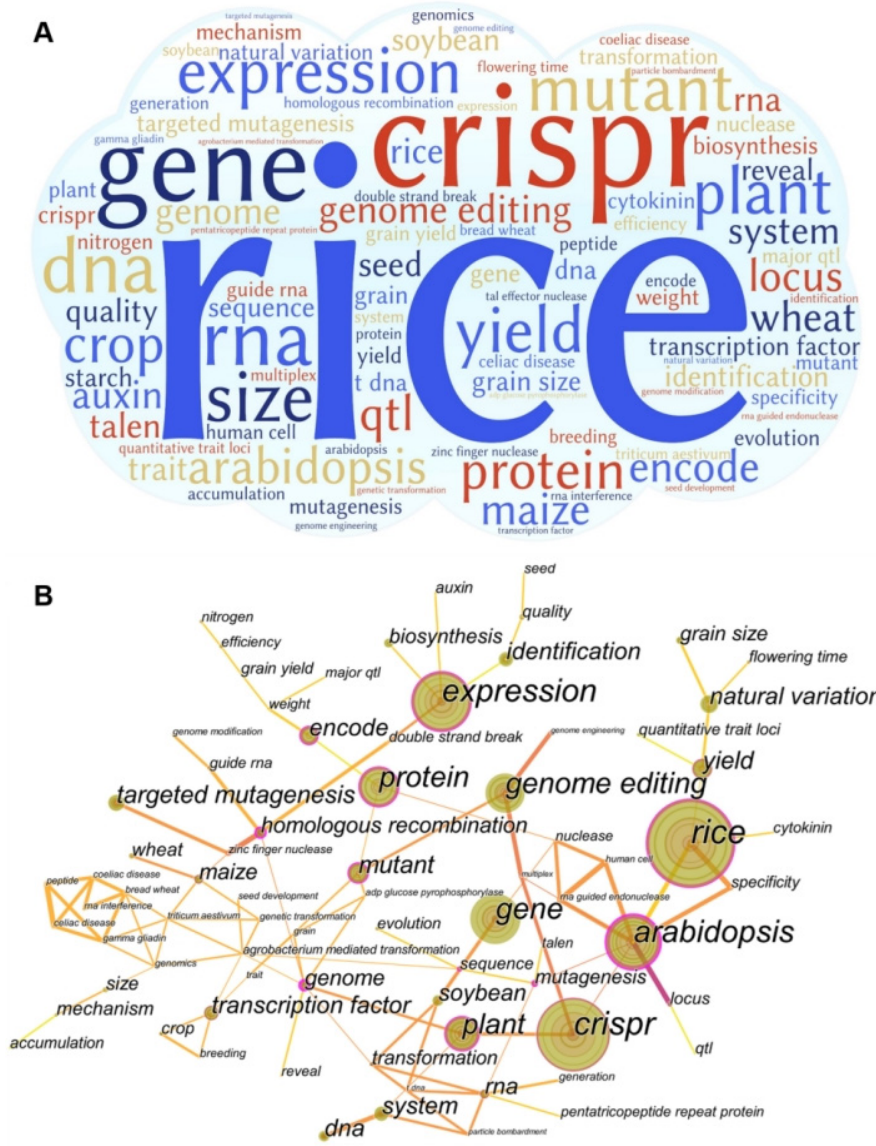
Figure 3. Research hotspots and trends. ( A ) Global gene editing research word cloud; ( B ) global gene editing research word cloud collinear diagram.